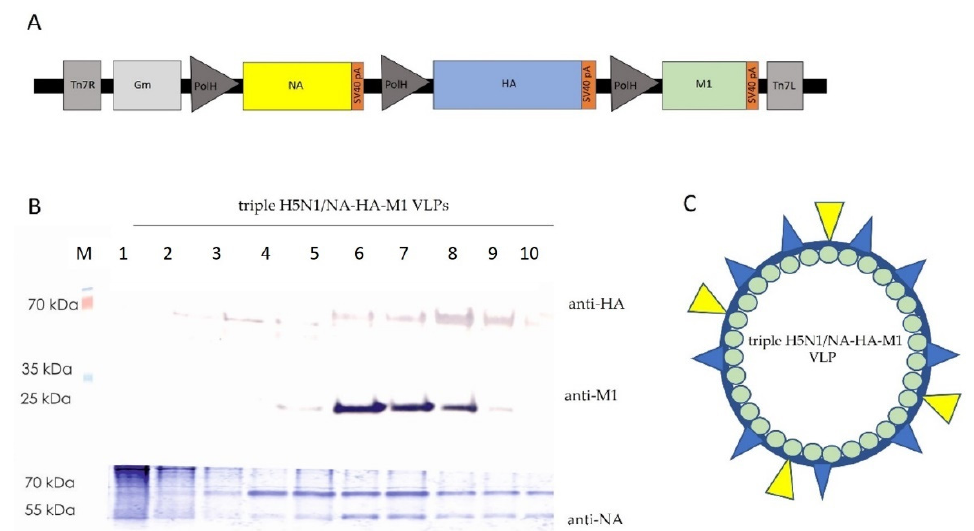
Figure 1. Production of H5N1 avian influenza triple H5N1/NA-HA-M1 VLPs. ( A ) Schematic representation of the tricistronic expression cassette. ( B ) Western blotting analysis of NA-HA-M1 VLPs purified on a 10%–60% sucrose gradient. Antibodies used for the detection of HA, NA and M1 proteins: mouse monoclonal anti-HA H5N1 antibodies, mouse monoclonal anti-M1 influenza antibodies and rabbit polyclonal anti-avian influenza A neuraminidase antibody. ( C ) Schematic representation of the predicted structure of triple H5N1/NA-HA-M1 VLPs. Structural proteins are color-coded according to the scheme of the expression cassette: NA—yellow, HA—blue, M1— green.